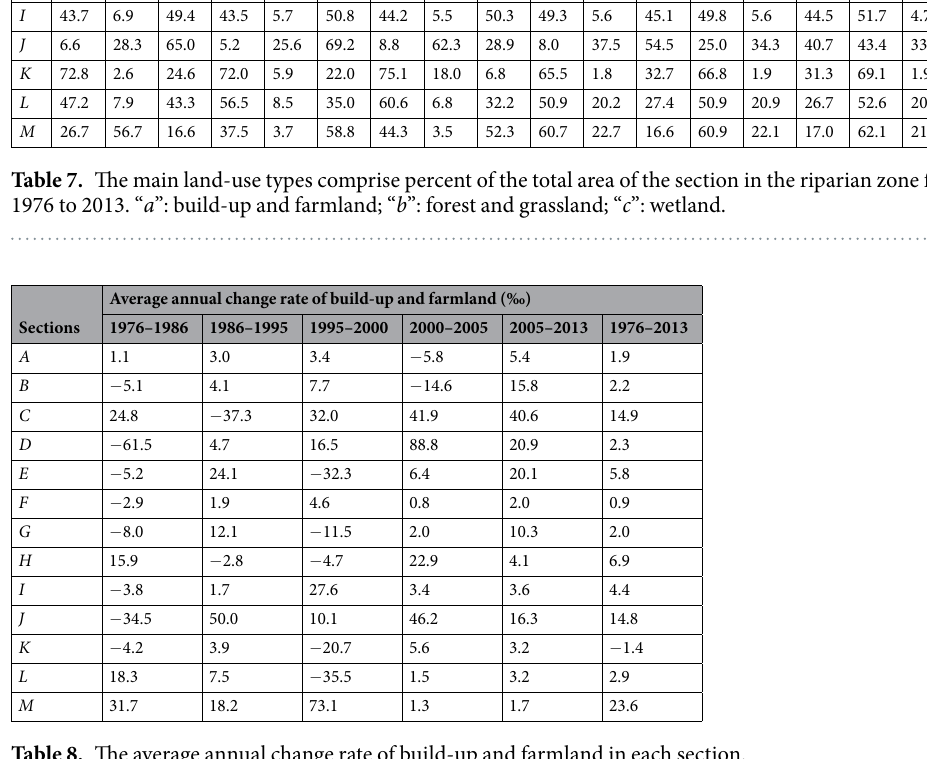
Table 8. The average annual change rate of build-up and farmland in each section.